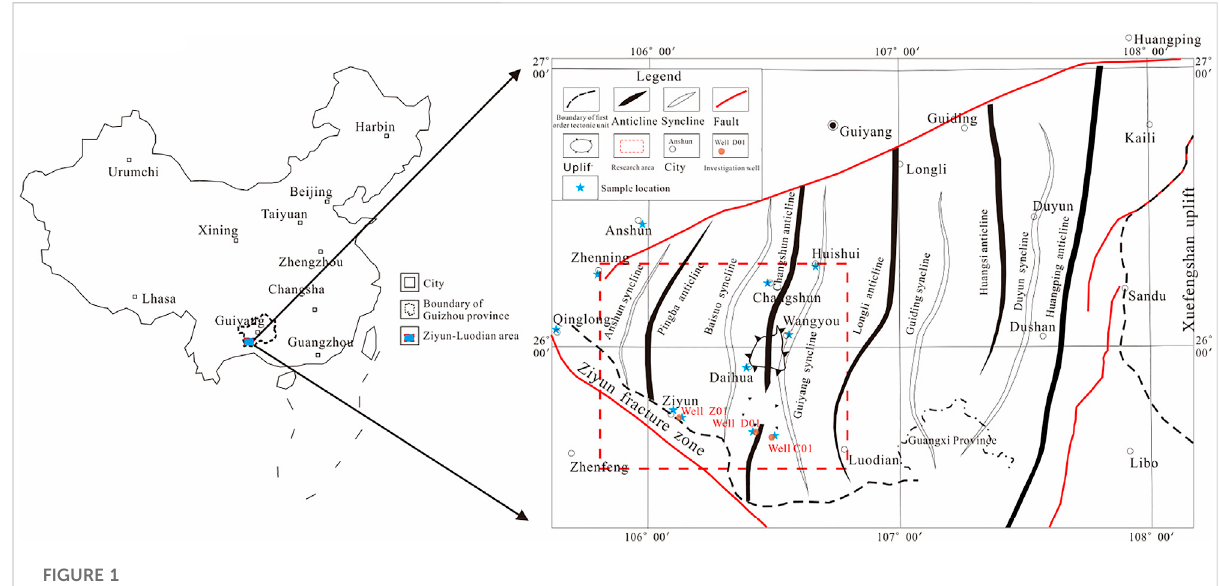
FIGURE 1 Structure outline and sample locations in the research